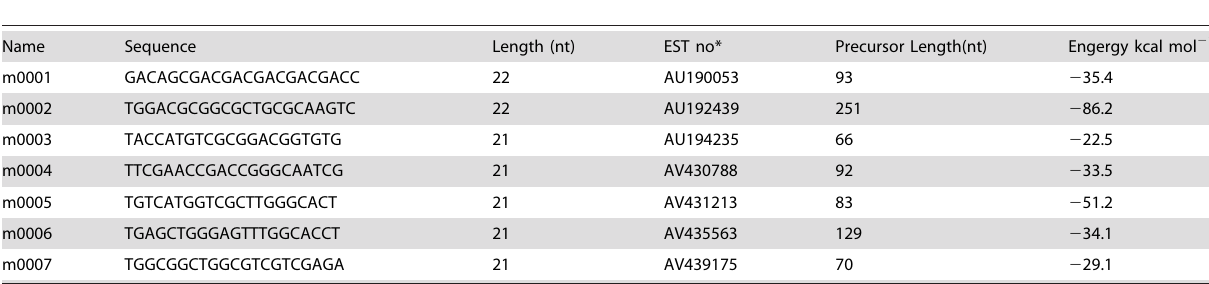
Table 2. 7 novel miRNA predicted in P. yezoensis